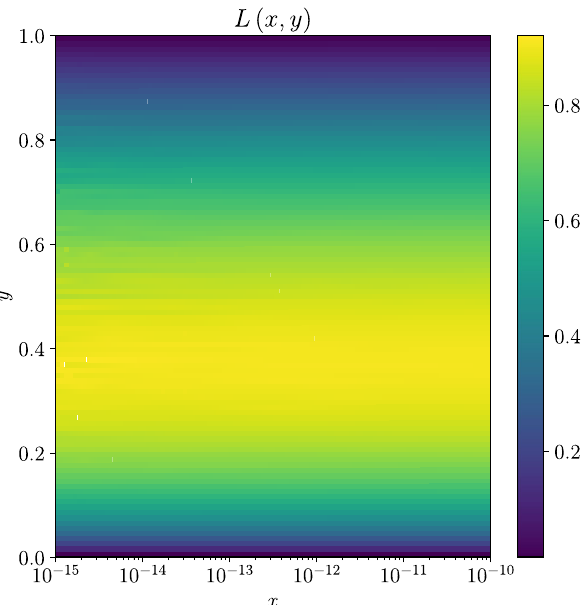
Fig. 5 For the SM particle content we display the kernels L ( x , y ) = AL A ( x , y ) + BL B ( x , y ) for x ∈ [ 10 − 15 , 10 − 10 ] and y ∈ [ 0 , 1 ]